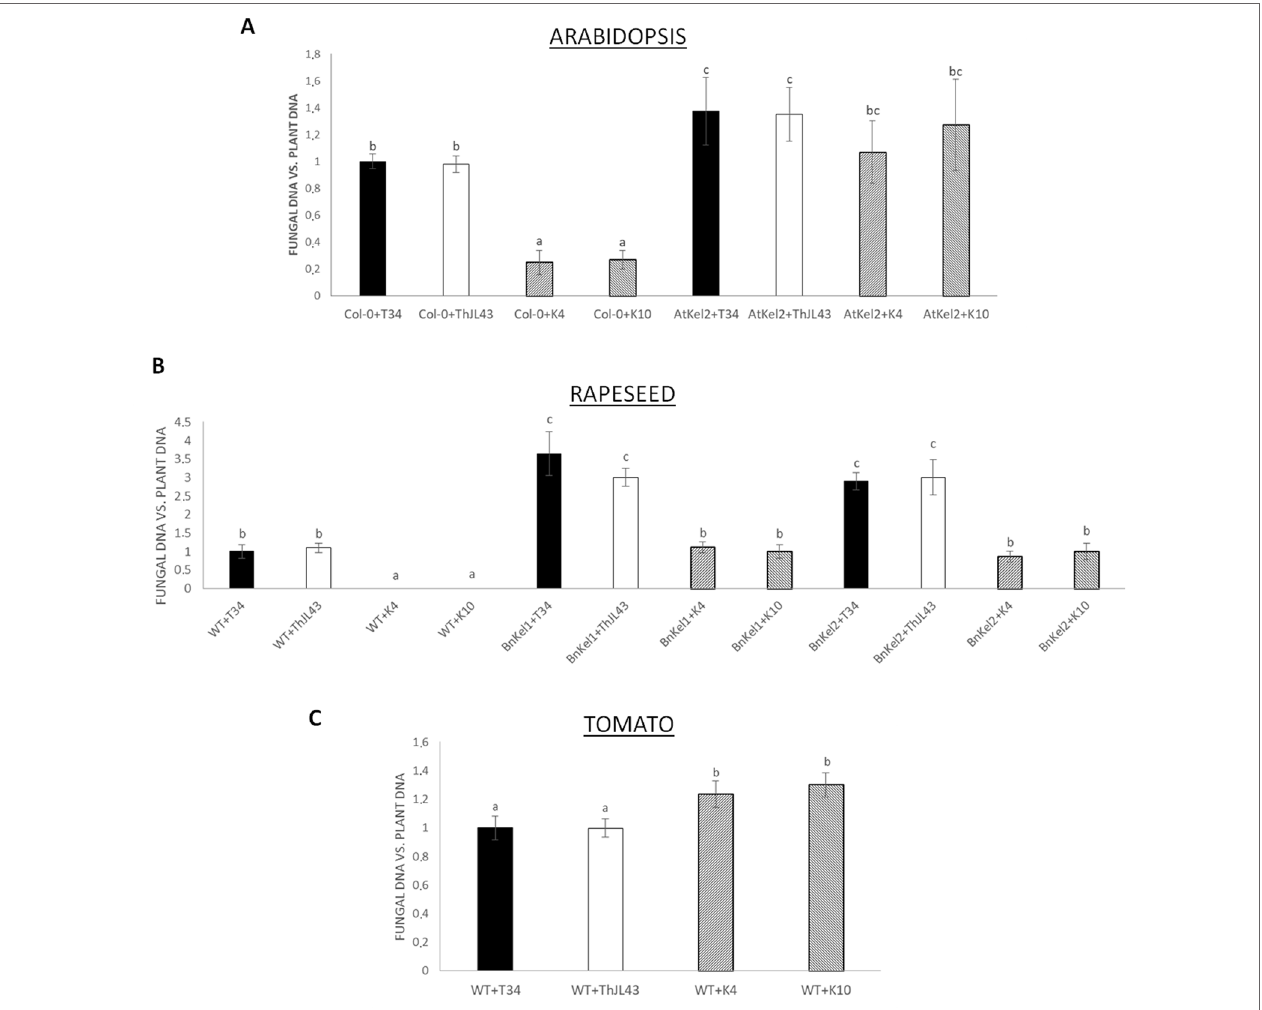
FIgURE 5 | Analysis of root colonization by T. harzianum (T34: control strain; ThJL43: transformation control; K4 and K10: silenced transformats for the Thkel1 gene) in hydroponic culture of A . thaliana (a) , rapeseed (B) , and tomato (C) in a greenhouse. To quantify Arabidopsis , rapeseed, and tomato root colonization, the DNA of the fungus was quantified by qPCR from radicular samples using the actin genes from both the plants and the fungus. Data are the mean of three biological replicates for each condition with the corresponding standard deviation, and for each biological replicate and condition, roots from five plants were used. One-way analysis of variance (ANOVA) was performed, followed by the Tukey’s test. Different letters represent significant differences ( P < 0.05).